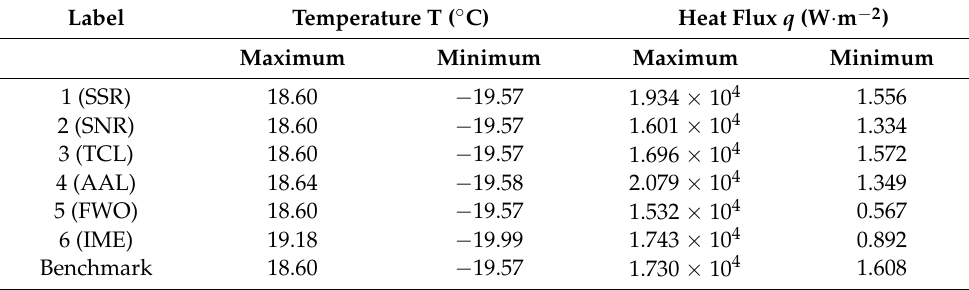
Table 8. Description of Improvement Approaches.